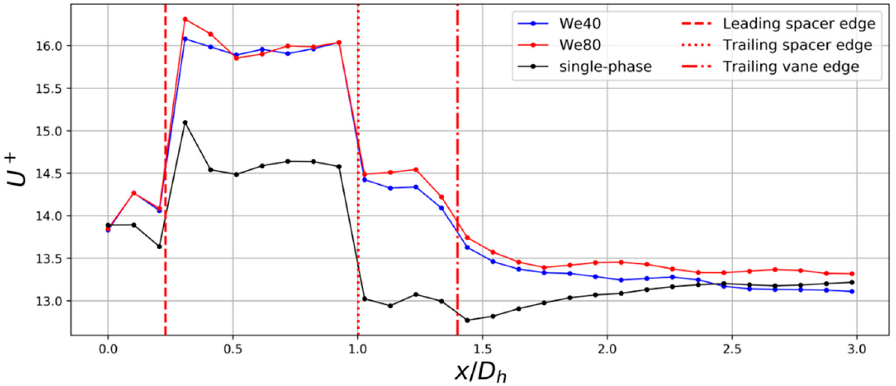
Figure 11. Axial evolution of plane averaged normalized mean streamwise velocity profile for the single-phase, We40 and We80 cases.